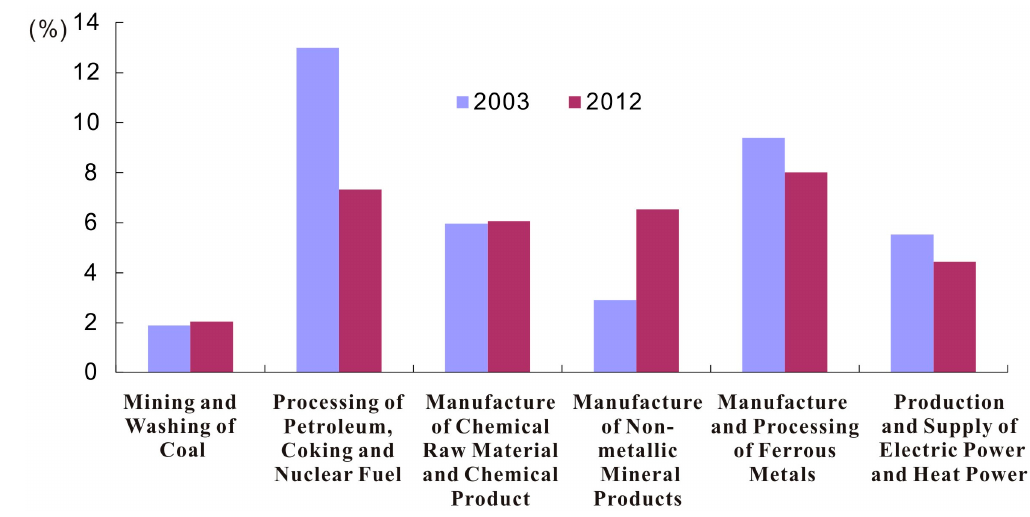
Figure 2. The output value share of top six energy-consuming subsectors in 2003–2012. Table 2. Impact of different factors on the changes of industrial energy consumption in NOIB,